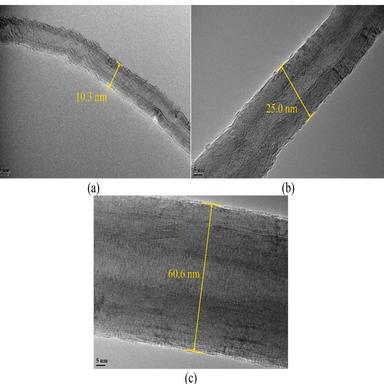
TEM images showing the diamters of CNTs: (a) N10; (b) N20; (c) N50.